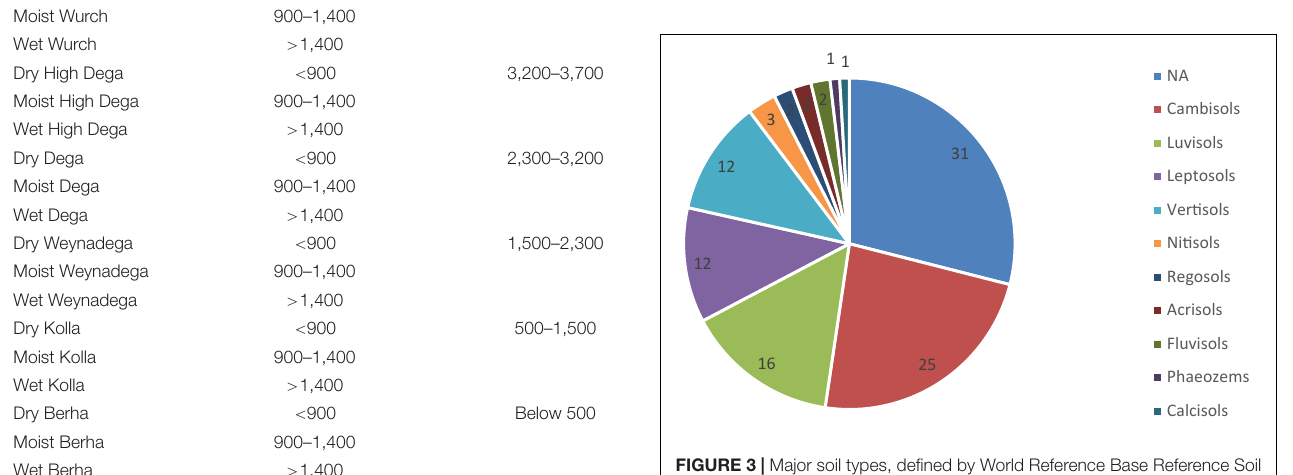
Frontiers in Ecology and Evolution |